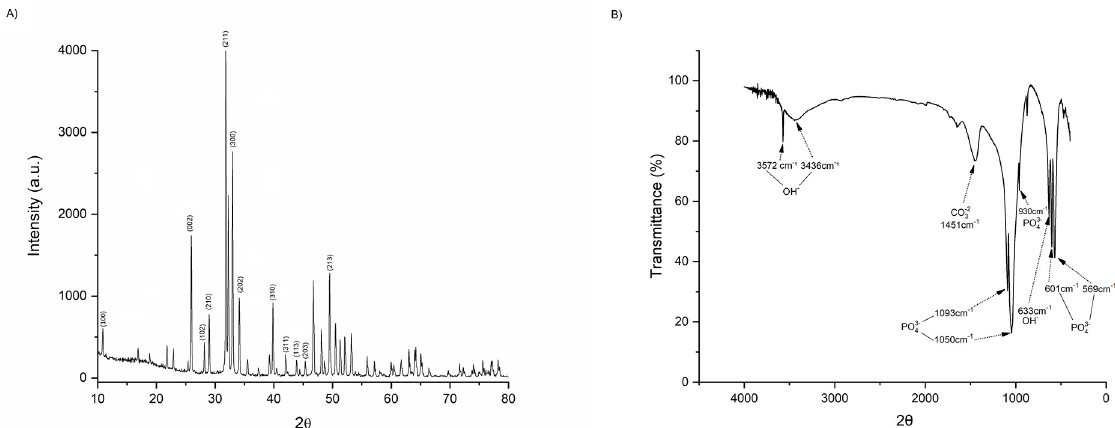
Figure 2. XRD structure of HADOX microsphere presenting the expected features of a stoichiometric hydroxyapatite configuration ( A ) and HADOX microsphere FTIR fields exhibiting (PO4)3 − and OH − bands ( B ).